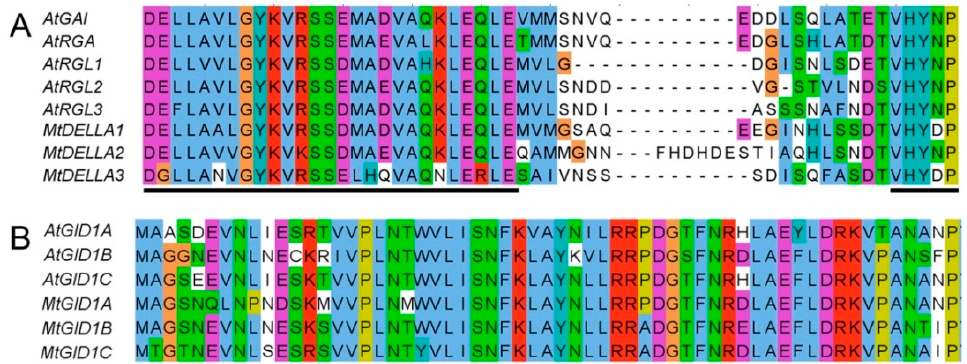
8 of 20 Figure 5. Expression patterns of MtDELLA ( A ) and MtGID1 ( B ) genes in six different tissues. R, roots; S, stems; L, leaves; SB, shoot buds; F, flowers; P, pods. The level of expression was normalized to M. truncatula UBI gene. Error bars represent SD for three biological replicates. 2.7. The GA Receptors, MtGID1s, Were Able to Interact with MtDELLA Proteins In DELLA protein, two important and conserved motifs, DELLA and VHYNP, are involved in the interaction with GID1 proteins [55,56]. In addition, the SUMO-Interaction Motif (SIM), which is important for the recognition of SUMOylated DELLA proteins, is also highly conserved between GID1s [57,58]. Multiple sequences alignment showed that the three MtDELLA proteins had the typical DELLA and VHYNP domains (Figure 6A; Figure S11) and the three MtGID1 receptors had the conserved DELLA interaction SIM motif (Figure 6B; Figure S11). To verify that the MtDELLA and MtGID1 proteins are functional GA signaling components, we assessed the interaction between MtDELLAs and MtGID1s using the yeast two-hybrid system (Figure 7). We also performed the